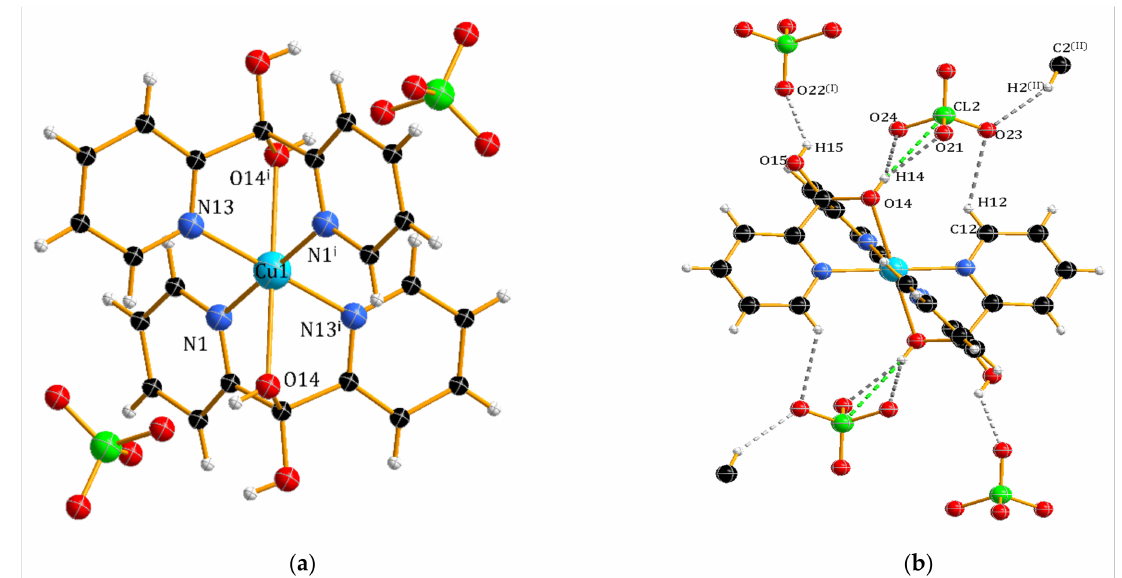
Figure 5. ( a ) Molecular structure of [Cu(py 2 C(OH) 2 ) 2 ](ClO 4 ) 2 ( 5 ) and ( b ) the C-H ··· O and O-H ··· O interactions in crystal structure of the